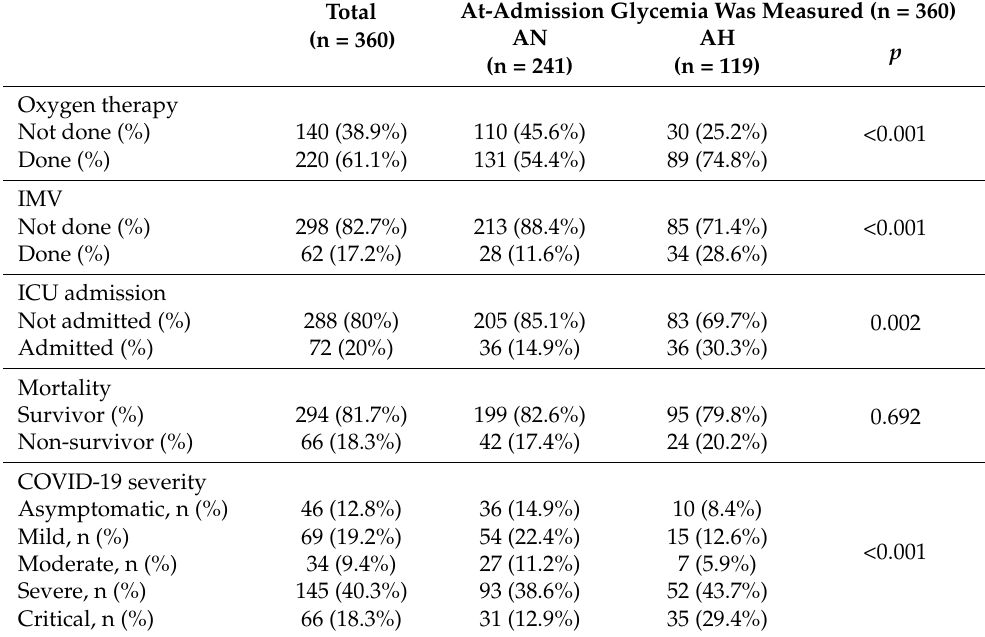
Table 4. Clinical outcomes according to at-admission glycemia.